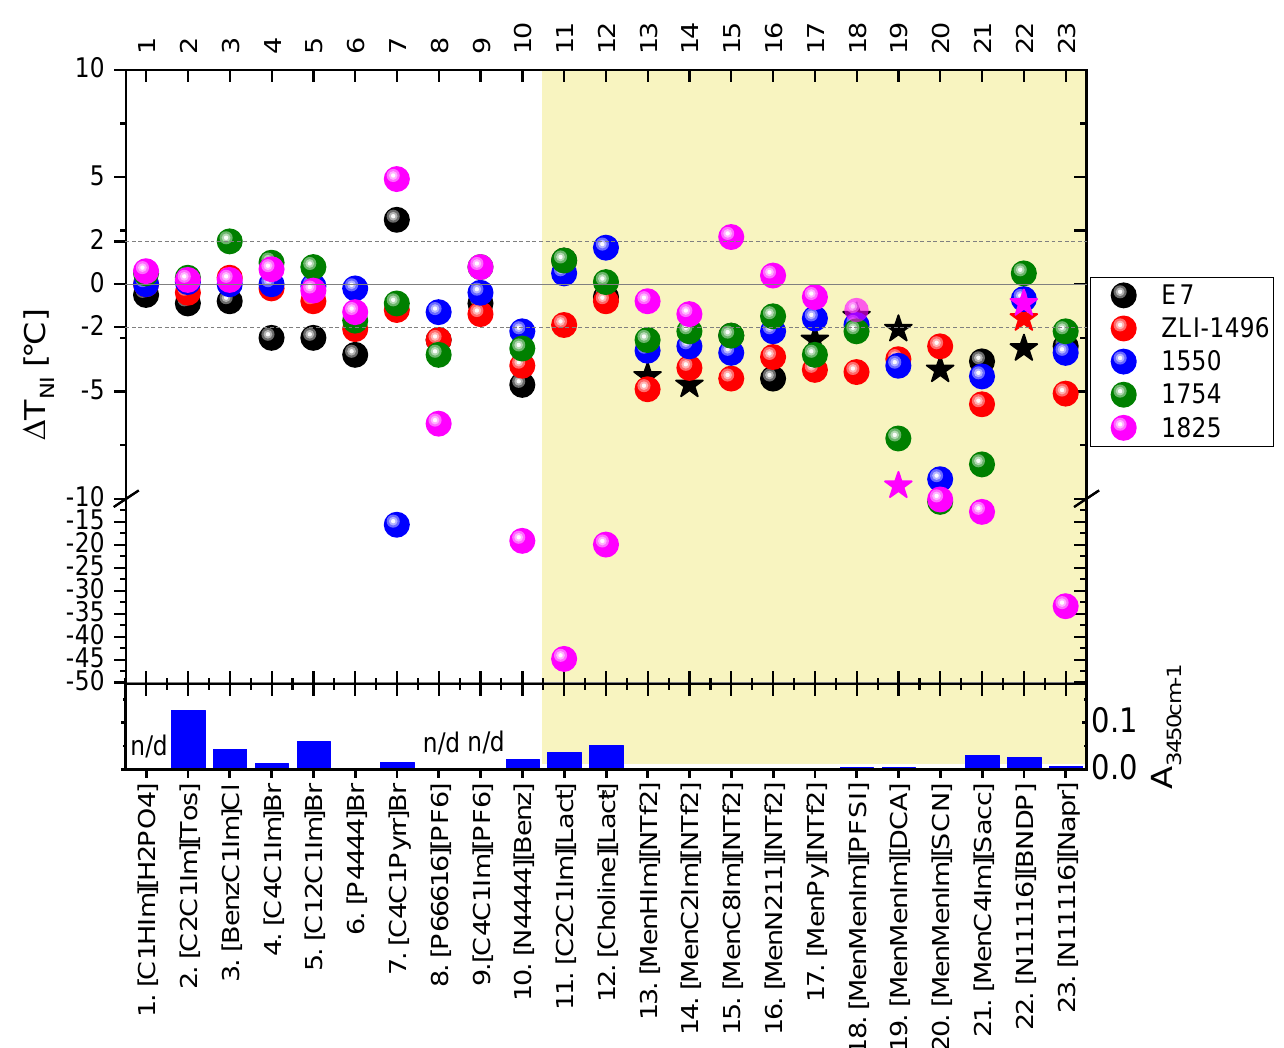
Figure 3. Shift in the isotropization temperature of the nematic phase ( ∆ T NI ) in the studied mixtures of LCs doped with 4.4–5.4 wt% (or 20 ± 1 wt%—in case of some mixtures with ILs nos. 11 and 12) of ILs . Dotted lines at ± 2.0 ◦ C indicate a range of double value of uncertainty of the measurement ( ± 2 u ) around the T NI of the LC host. The star symbols in the graph indicate induction of the twisted nematic phase in the mixtures. The results are also presented in the Table S3 in the Supplementary Materials. The column graph below presents the parameter A 3450cm − 1 , related to the water content of the ILs . Mixtures with CILs are highlighted by yellow background color. Details are described in the text.